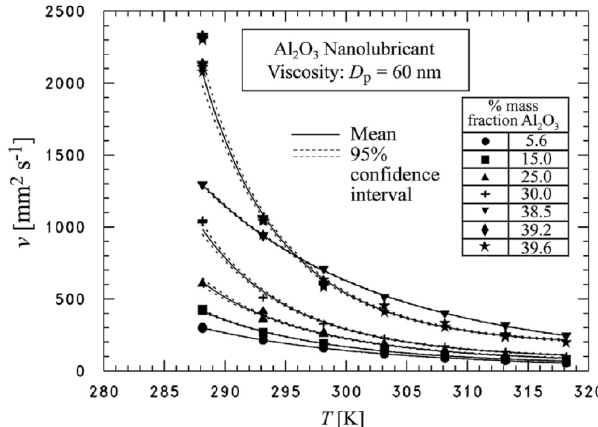
Figure 7. Kinematic viscosity of Al 2 O 3 nanolubricant with 10 nm diameter nanoparticles for various mass fractions and temperatures (measured at atmospheric pressure) [31].